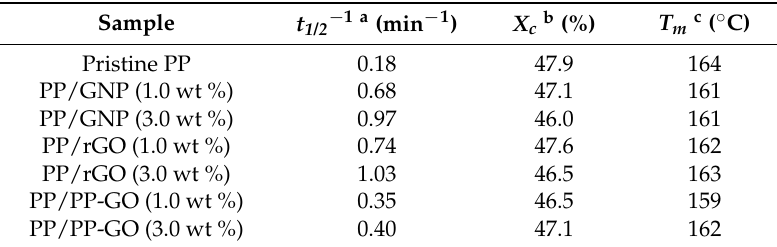
Table 2. DSC results for PP nanocomposites.